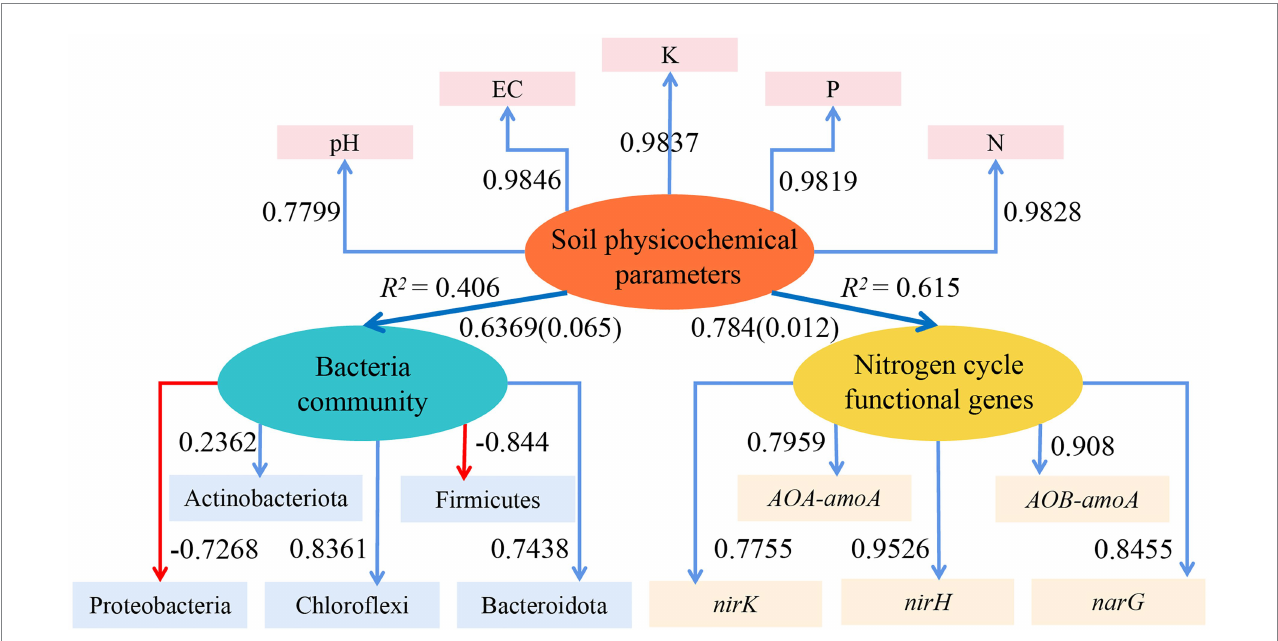
FIGURE 8 PLS-EM model to analyze the effect of the soil physicochemical parameters on the dominant bacterial community and functional genes of the nitrogen cycle. Blue arrows in the Figure indicate positive correlations, red arrows indicate negative correlations, numbers on the arrows indicate standardized path coefficients, and values in parentheses are significant p- values; ovals indicate potential variables, and squares are measured variables; R 2 next to the variables is the explained